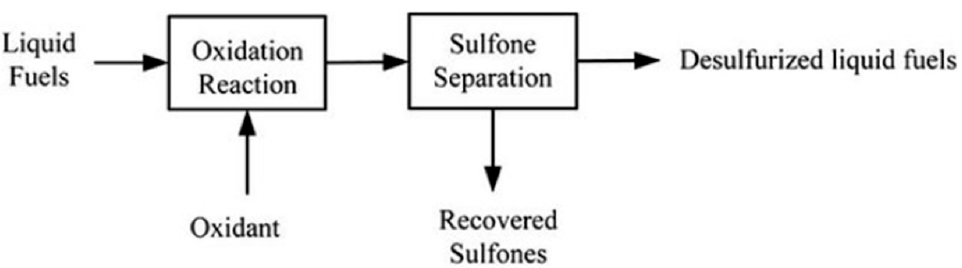
Figure 3. Oxidative desulfurization fl ow